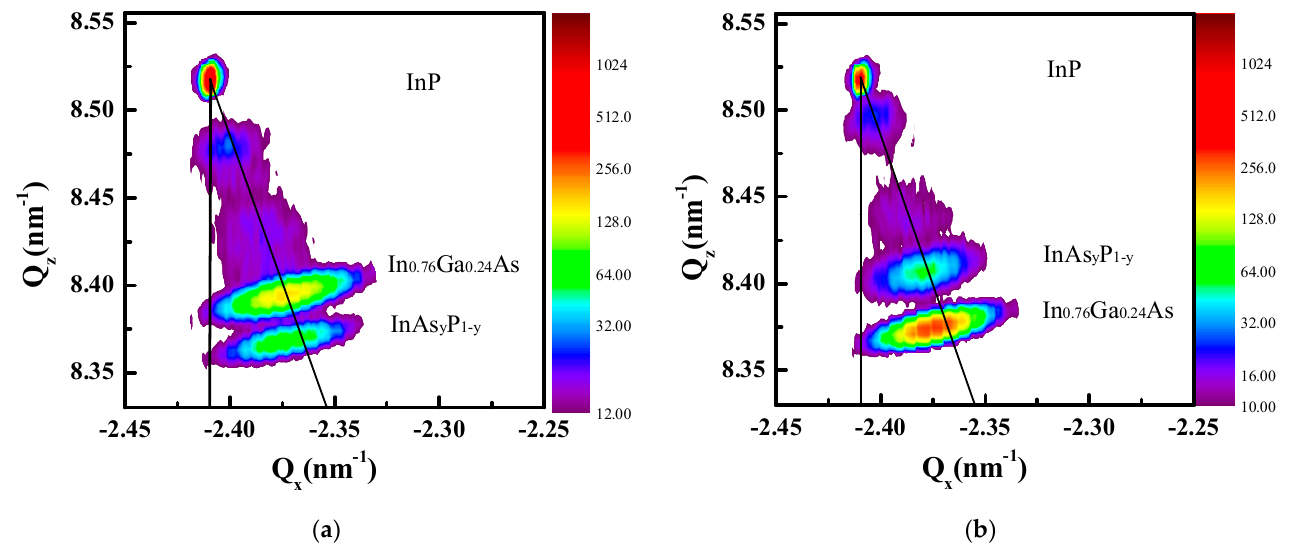
Figure 3. Asymmetric (115) RSMs of extended wavelength InGaAs on InP substrate: ( a ) sample A (R = 96.47%); ( b ) sample B (R = 85.12%).